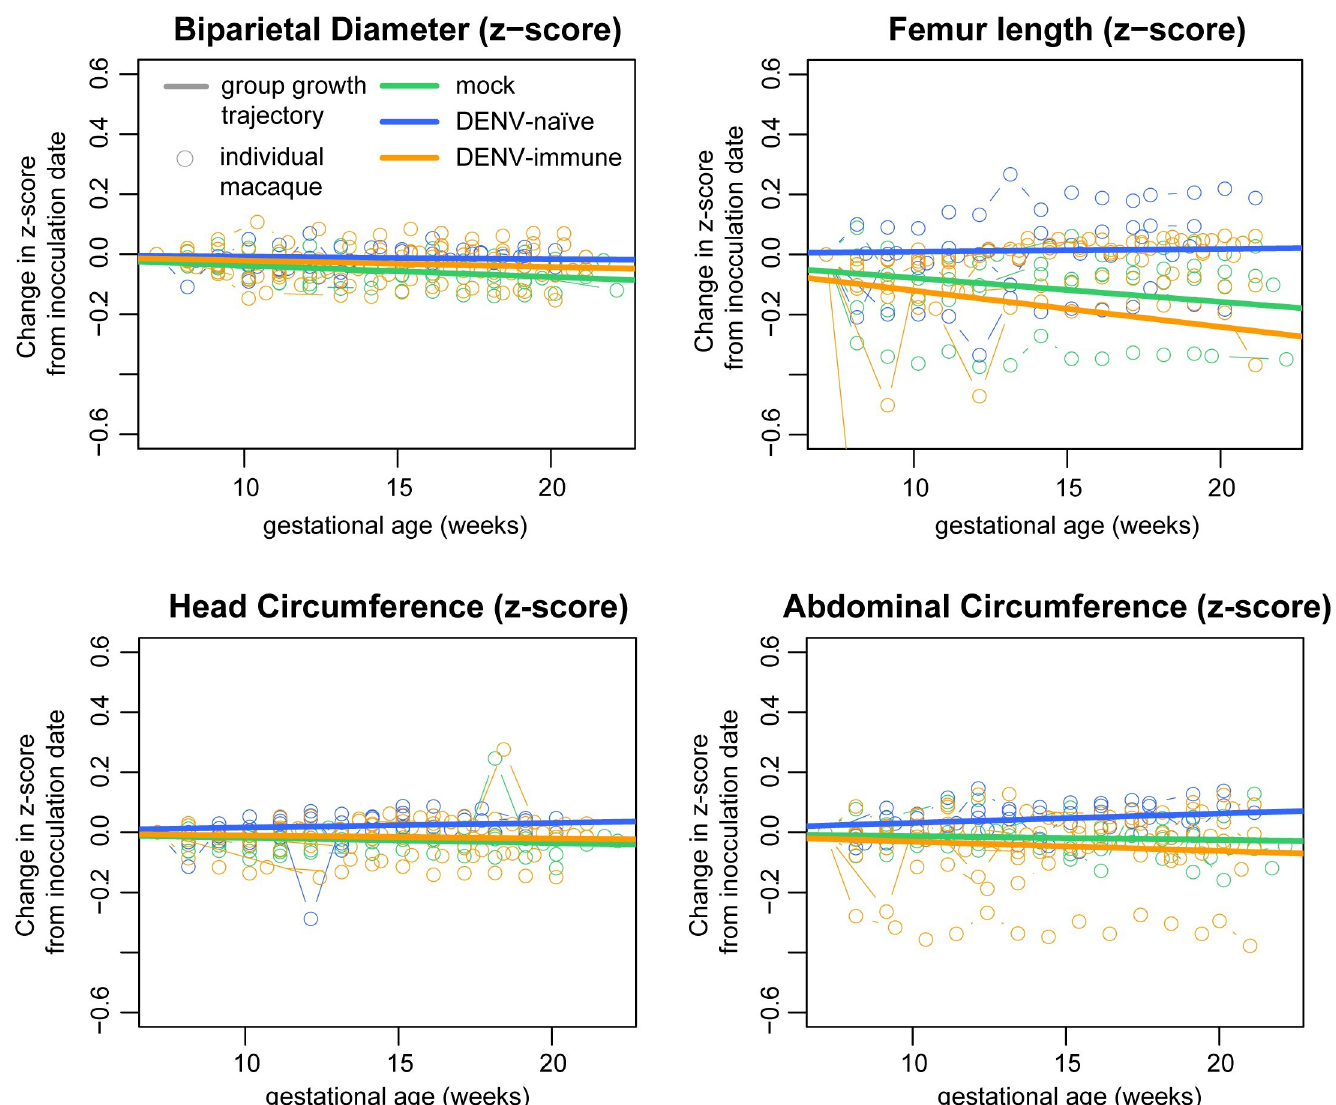
Fig 5. Fetal Growth. Comprehensive ultrasounds were performed weekly throughout gestation to monitor fetal health and perform four measurements of fetal growth: biparietal diameter and head circumference to evaluate head size; abdominal circumference and femur length to evaluate overall fetal growth. Using normative data from the California National Primate Research Center, a z-score was calculated for each measurement and the change in z-score from baseline is plotted for each measurement with an open circle. The overall growth trajectory for each group was quantified by calculating the regression slope parameters from baseline (solid line). When compared to the normative data, mock-infected animals had significantly reduced biparietal diameter growth (p = 0.01713). No other significant differences were detected in comparisons to the normative data or in comparisons between the experimental groups.